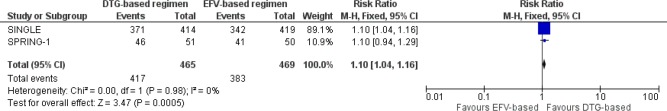
DTG + two NRTI vs. EFV + two NRTIs.Viral suppression to non-detectable (<50 copies/mL) at 48 weeks.